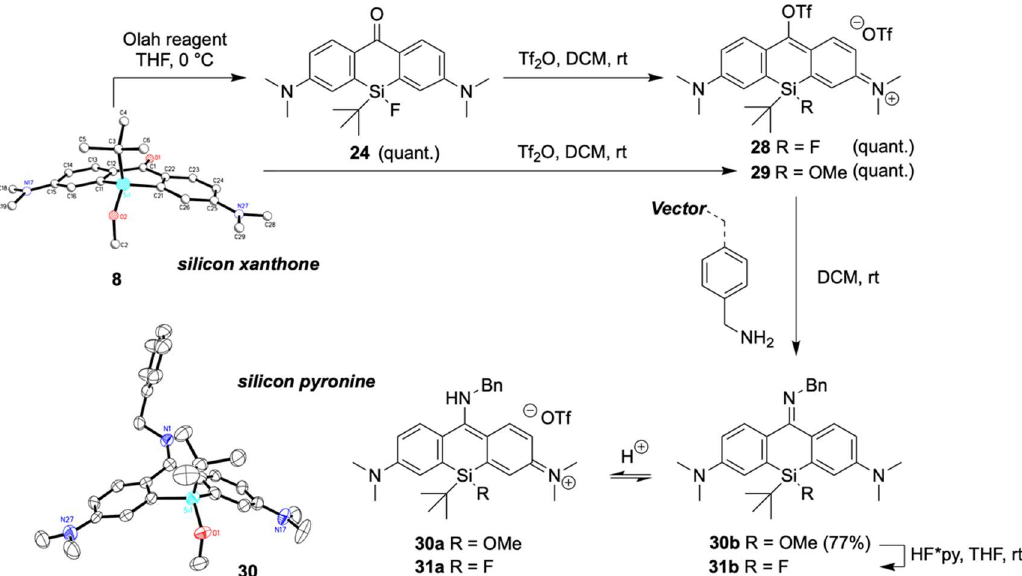
Figure 6. The silicon-substituted pyronines 30 and 31 could be obtained over two reaction sequences. Benzylamine was used as a model amine representative for any amine functionality of various targeting vectors, which can be ligated with the pyronine tag. In polar solvents and at low pH, the pyronines can adopt a zwitterionic structure ( 30a and 31a ), which exhibits NIR properties.